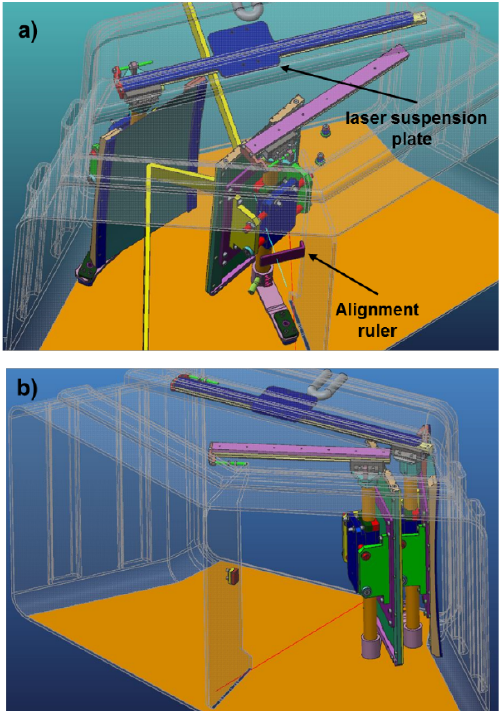
Fig. 3. Mirror positions during plasma operation (a) and during maintenance (b) . Elements for alignment are also show (see 3.2)